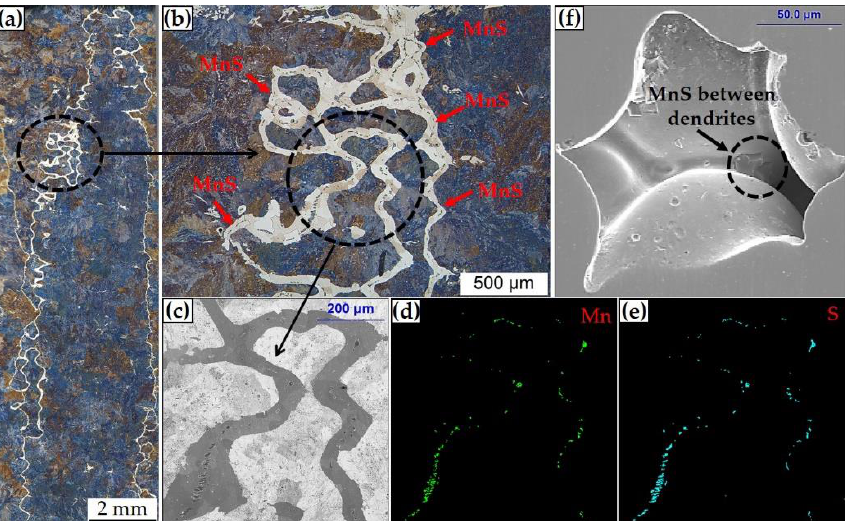
Figure 8. Relationship between MnS inclusions and solidification structure in the slab of medium carbon structural steel 45# revealed by experimental observation. ( a , b ) microstructure, ( c – e ) element mapping results, ( f ) MnS inclusion observed between dendrites.